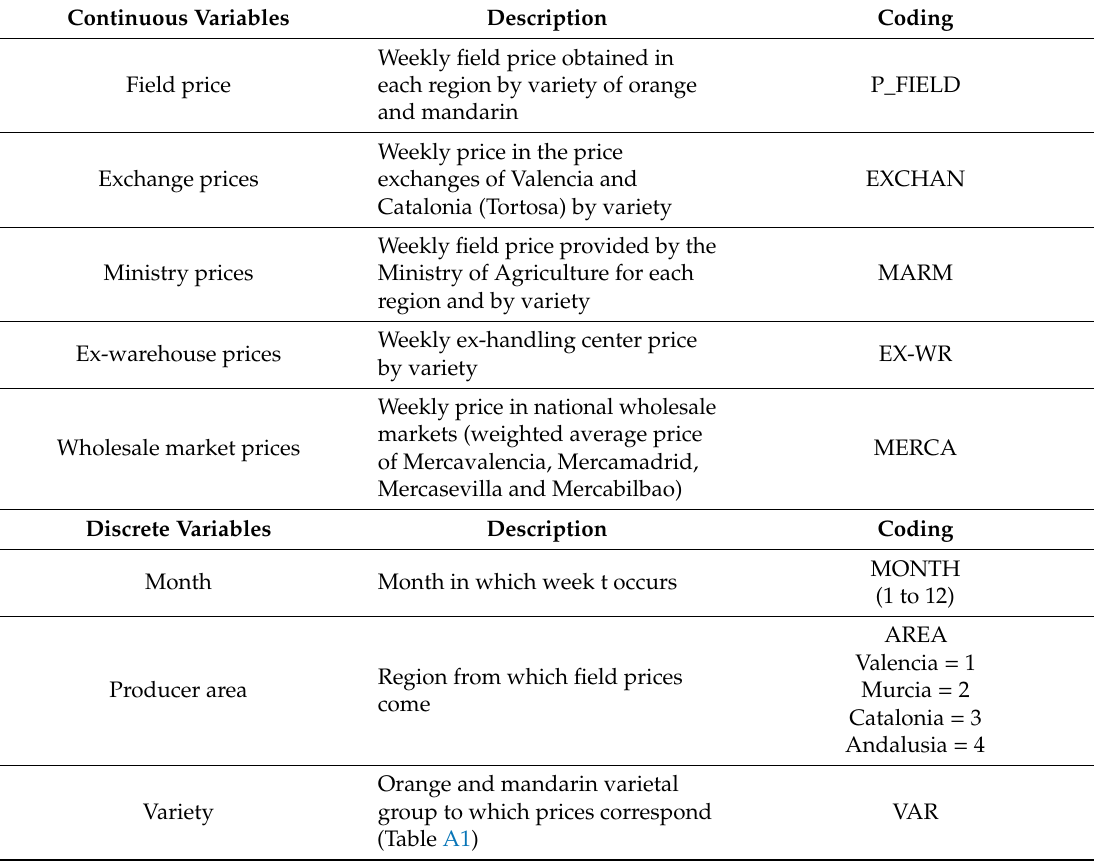
Table 2. Definition of